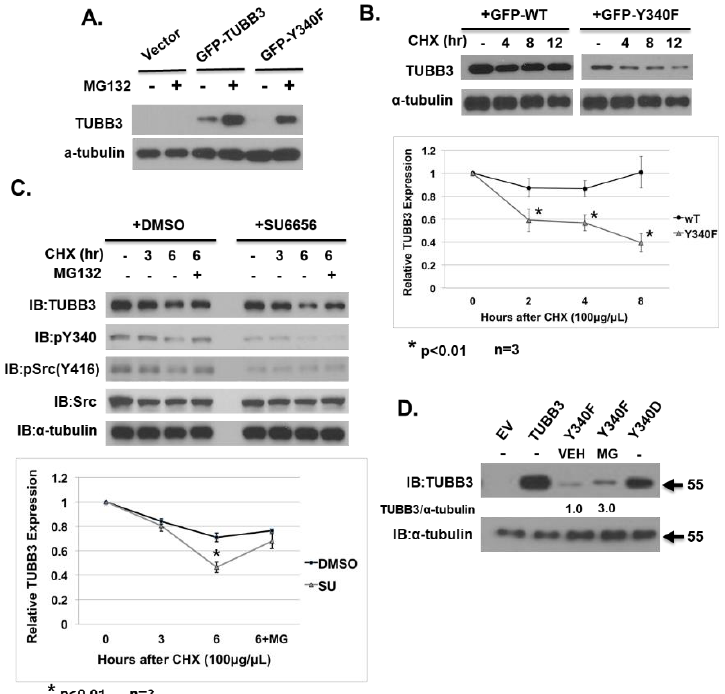
Figure 4. Phosphorylation of Y340 stabilizes TUBB3 protein. ( A ) COS-1 cells were transiently transfected with Empty Vector, GFP-TUBB3, or GFP-TUBB-Y340F. Cells were allowed to grow for 48 h post-transfection, then treated with either vehicle (DMSO) or proteasome inhibitor MG132. Cell lysates were subjected to immunoblotting with indicated antibodies. ( B ) Top panel, COS-1 cells were transiently transfected 24 h post-plating with either GFP-TUBB3 or GFP-Y340F. At 48 h post-transfection, cells were treated with cycloheximide (CHX) for indicated times. Cell lysates were subjected to immunoblotting with indicated antibodies. Bottom panel, densitometry quantification TUBB3/alpha-tubulin ratio of the top panel. ( C ) Top panel, R1/DTX cells were pretreated for 2 h with either vehicle or SU6656, then treated with CHX, or combined CHX/MG132 for indicated time points. Cell lysates were subjected to immunoblotting with indicated antibodies. Bottom panel, densitometry quantification of TUBB3/alpha-tubulin ratio of the top panel. ( D ) HEK-293T cells were transiently transfected with untagged human TUBB3 constructs (empty vector (EV), Wild-type (WT), Y340D, Y340F). At 48 h post-transfection, cells were treated with DMSO(VEH) or MG132(MG) for 24 h before cells were lysed. Cell lysates were then subjected to immunoblotting with indicated antibodies.